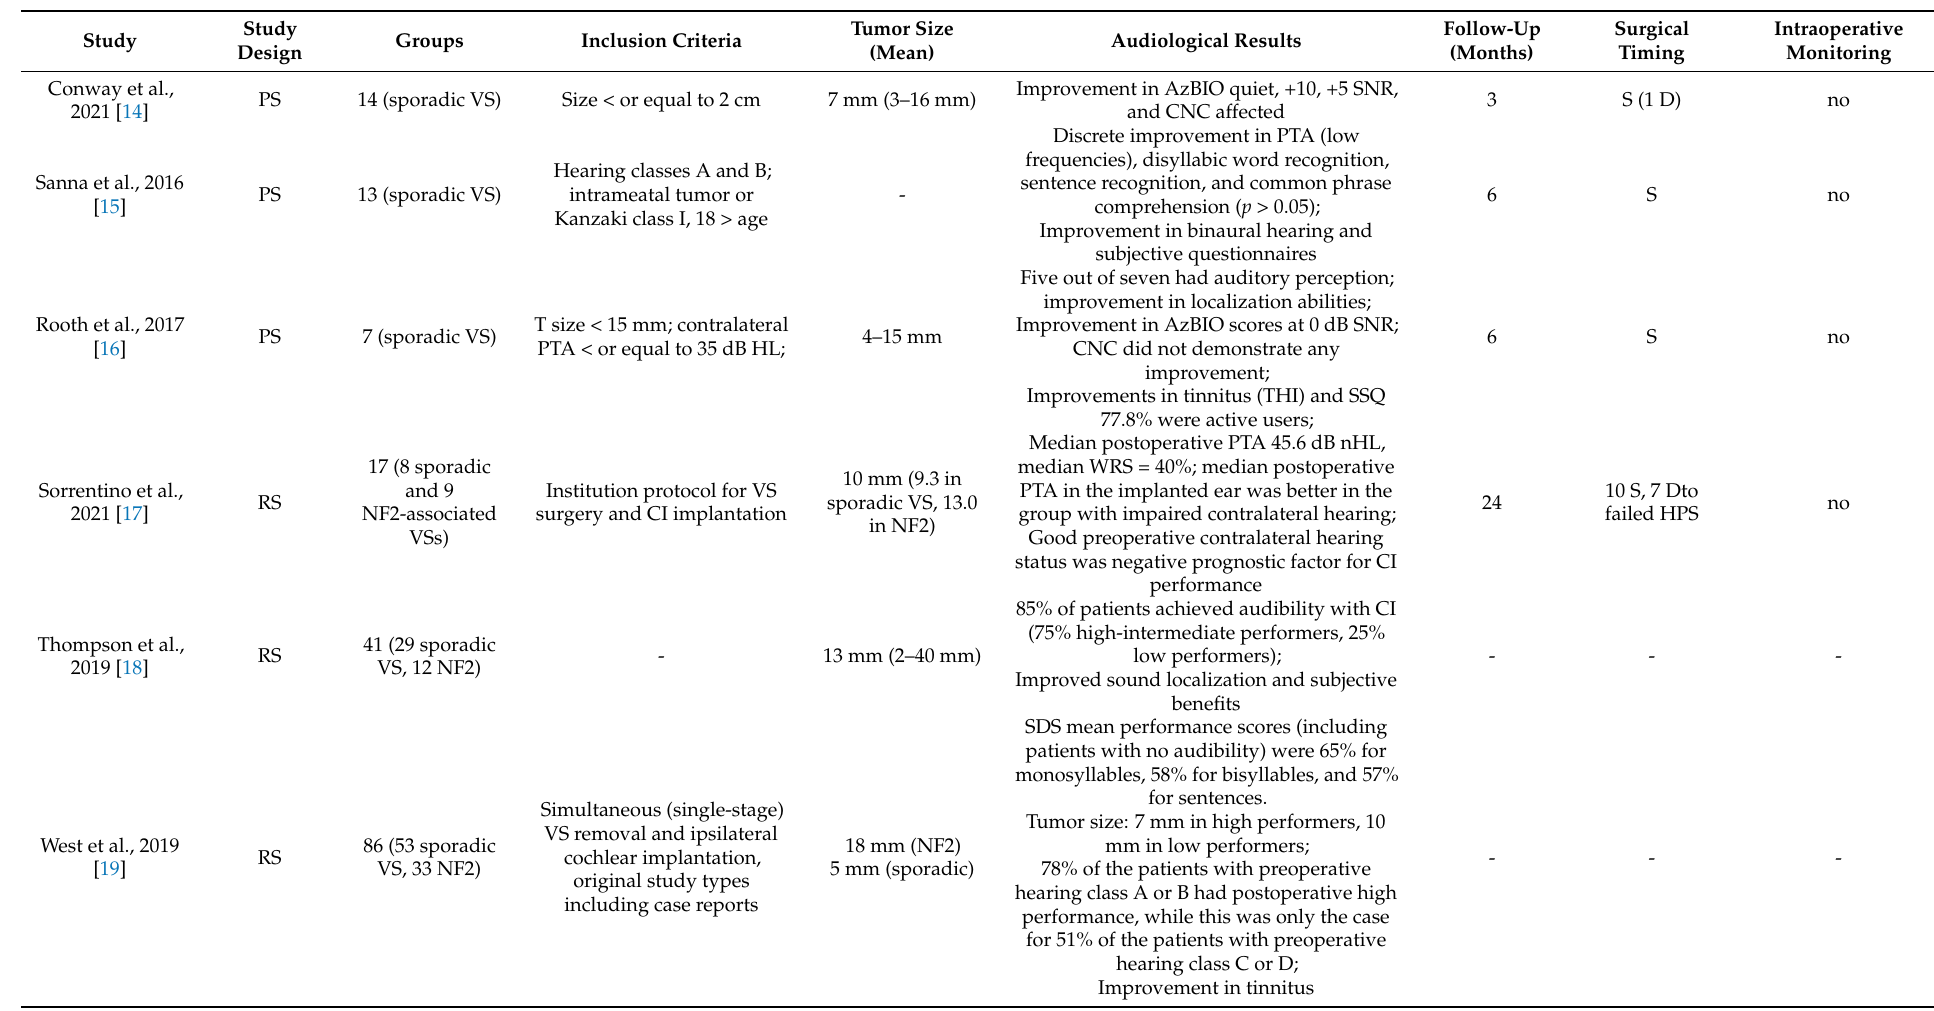
Table 1. Summary of paper’s